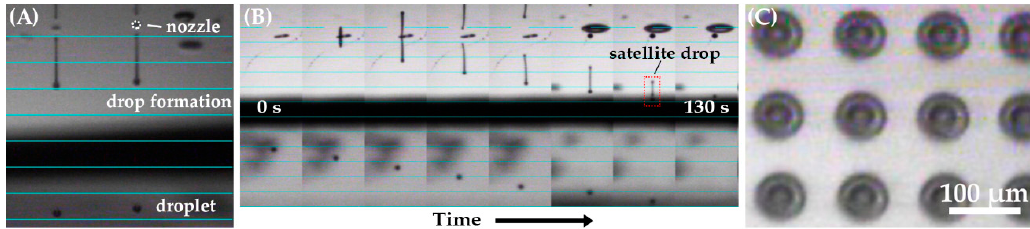
Figure 3. Drop visualization using Dimatix drop watch. ( A ) Jetting of two spherical pristine YBCO ink droplets from the nozzle in the air. ( B ) Time-resolved drop formation after the ejection of HfO 2 -YBCO ink in the air. A very small satellite droplet could be observed at t = 120 s (red dotted rectangle), which finally recombined with the main droplet. The blue lines are separated by 100 µm, and the time step in ( B ) is 15 s. ( C ) Optical images of the printed arrays on a LaAlO 3 substrate with a separation of 100 µm. The contact diameter of the drops was in the range 70–80 µm.